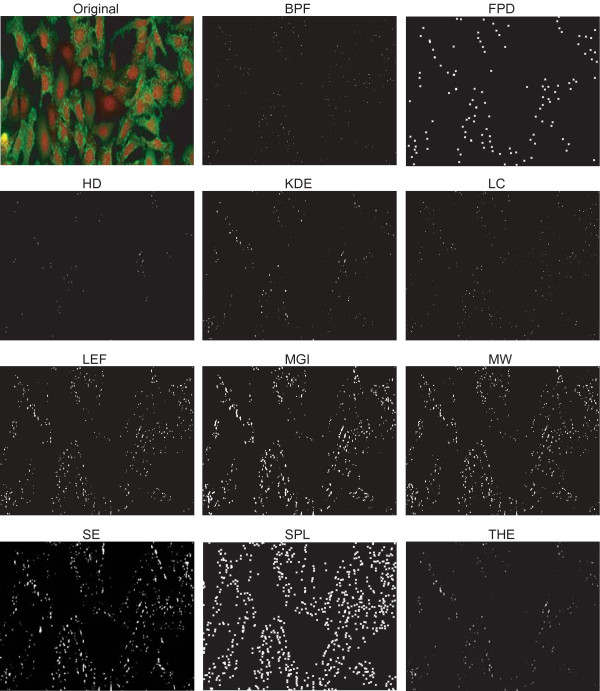
Example of well plate images and detection results by eleven algorithms. Note that the objects detected by FPD and SPL are illustrated as crosses whereas the actual segmentation results are shown for other algorithms. The original image has been contrast and intensity enhanced for illustration purposes.